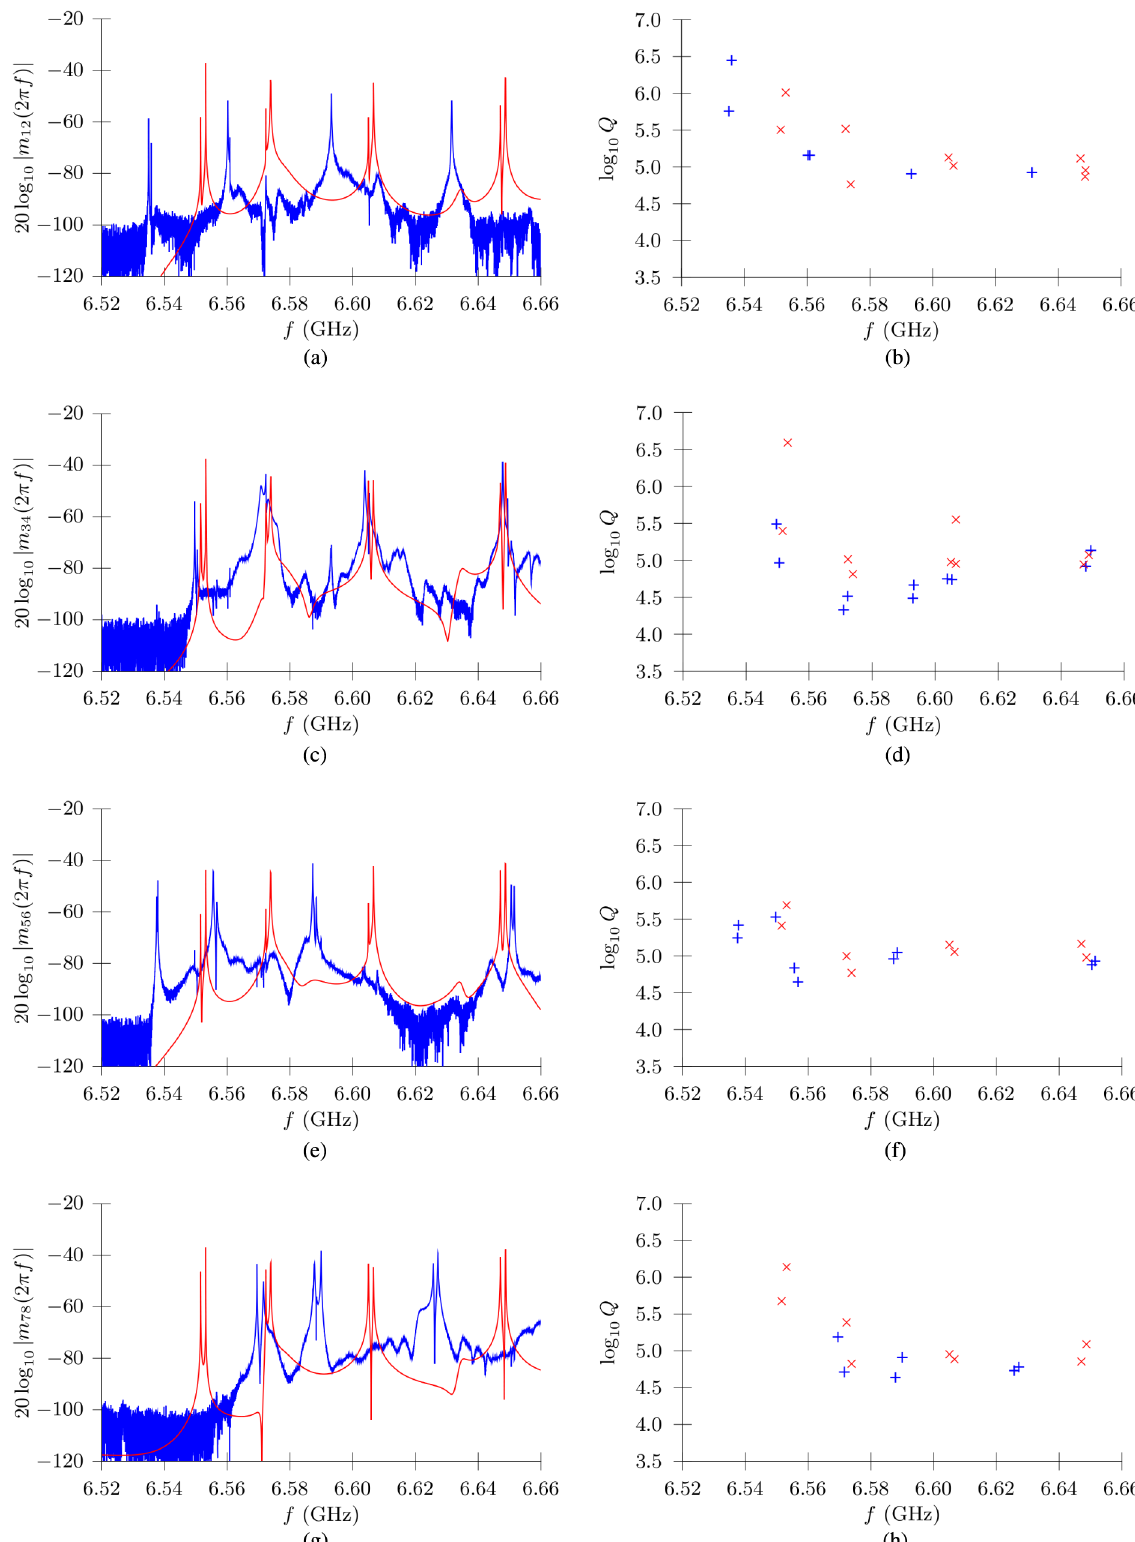
FIG. 13. Magnification of the transmission spectra corresponding to the quadrupole bands of all four cavities in the ACC39 string (left-hand side) and the resulting quality factors of the peaks computed by means of [27] (right-hand side). Blue curves and blue plusses represent measured data, whereas red curves and red crosses show the data obtained by simulation. The indices of the scattering parameters m (see ordinate labeling) refer to the port nomenclature presented in Fig. jk